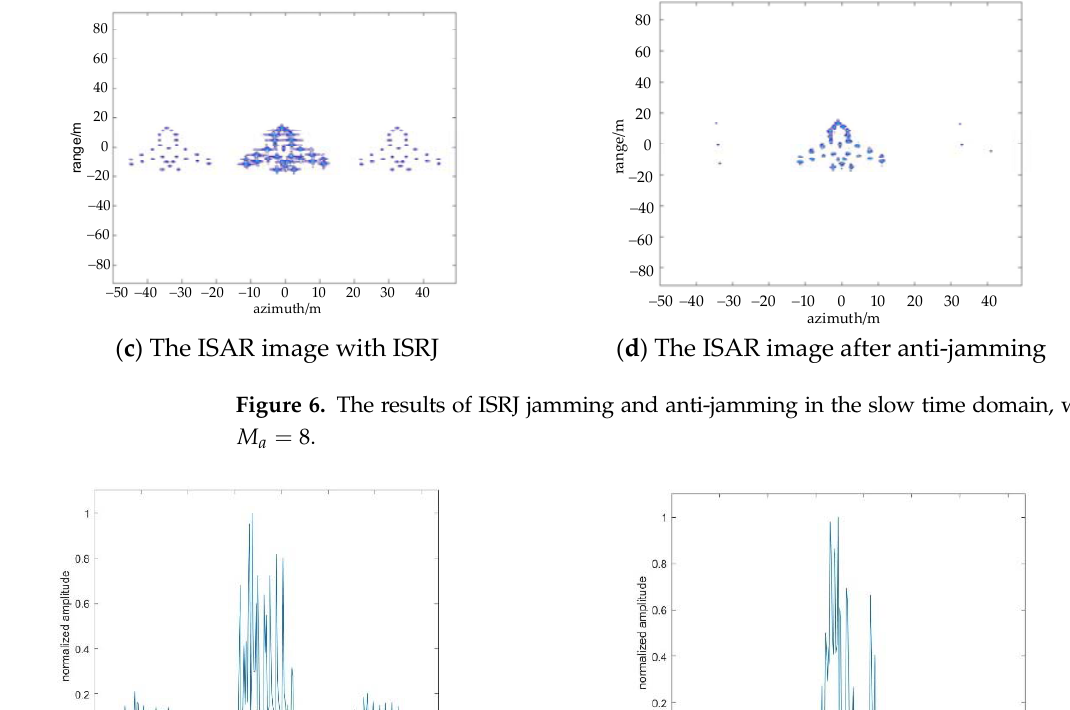
main middle target, while the other false targets cannot be reconstructed.